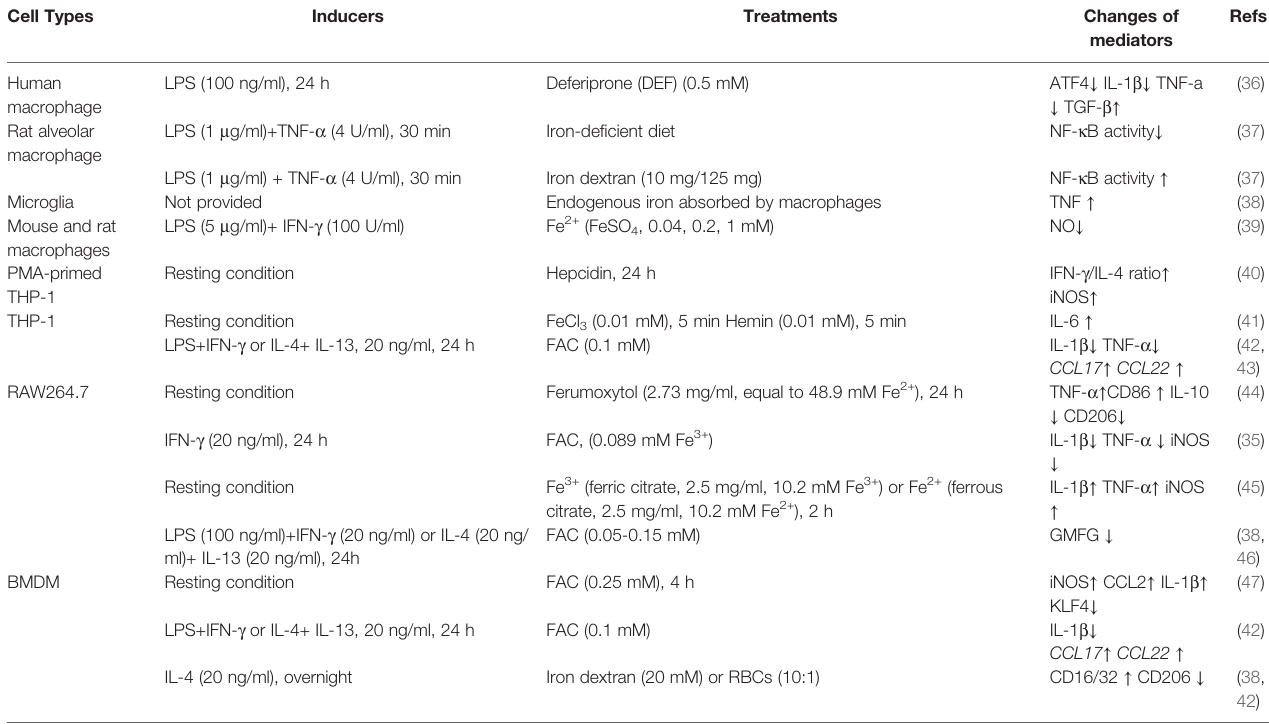
TABLE 1 | Iron affects macrophage